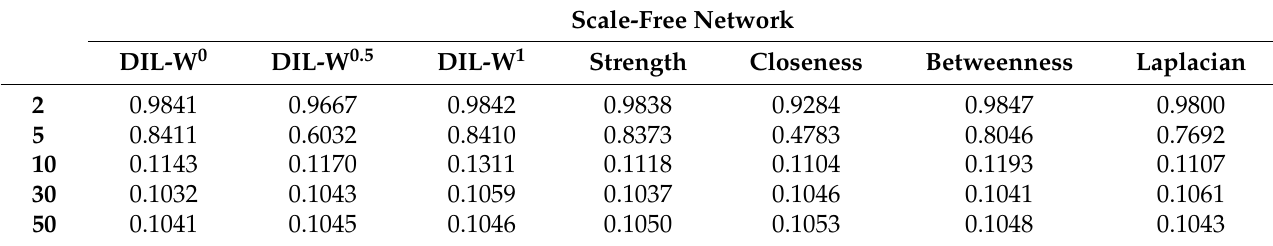
Table A6. σ according to different values of d in a Scale-free Network. Scale-Free